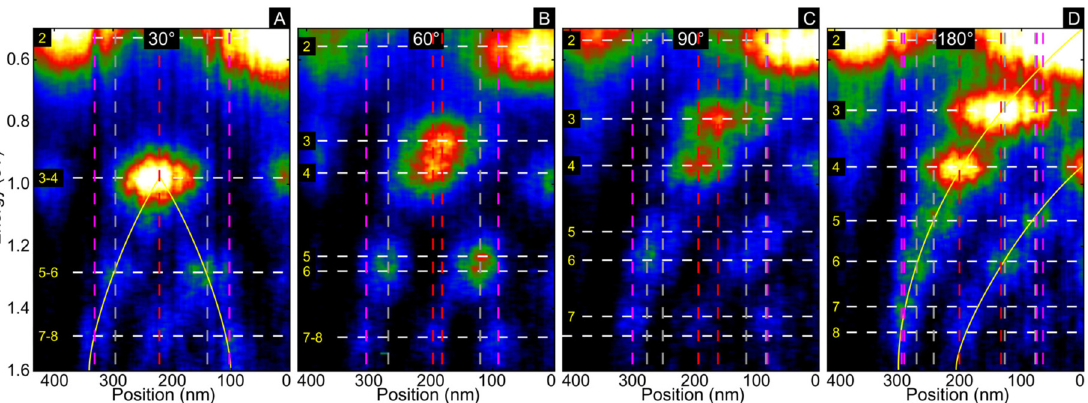
Figure 3: EELS intensity profiles of NWs with 30 ◦ (A), 60 ◦ (B), and 90 ◦ (C) bending angles, as well as of a straight NW (D). The figure shows how the nodal distribution of the NW modes changes due to the presence of a bend, inducing antinode bunching in energy and position. The EELS profiles are acquired over half of the NWs across their width in the regions indicated by the arrows in the ADF images in Figure 1. The vertical and horizontal lines are a guide to the eye of the center of the